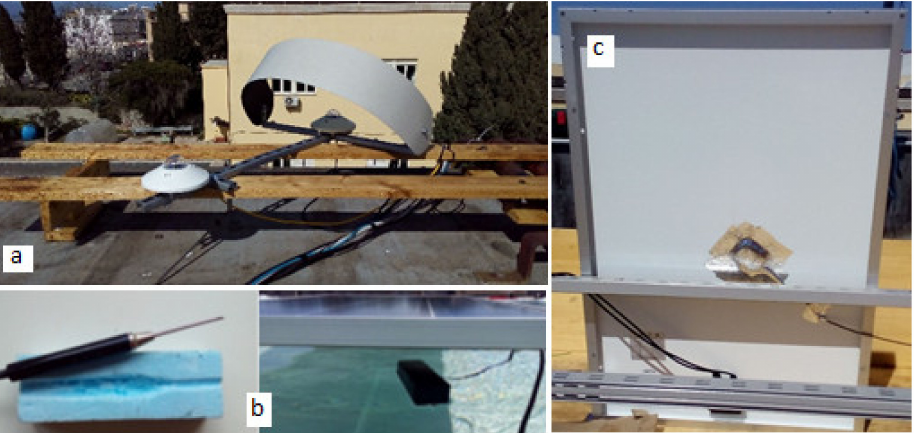
Figure 2. Measurement variables and instruments for experimental set-up. ( a ) pyranometer for global and diffuse radiation; ( b ) RTD for water temperature and ( c ) Thermocouple to measure the panel